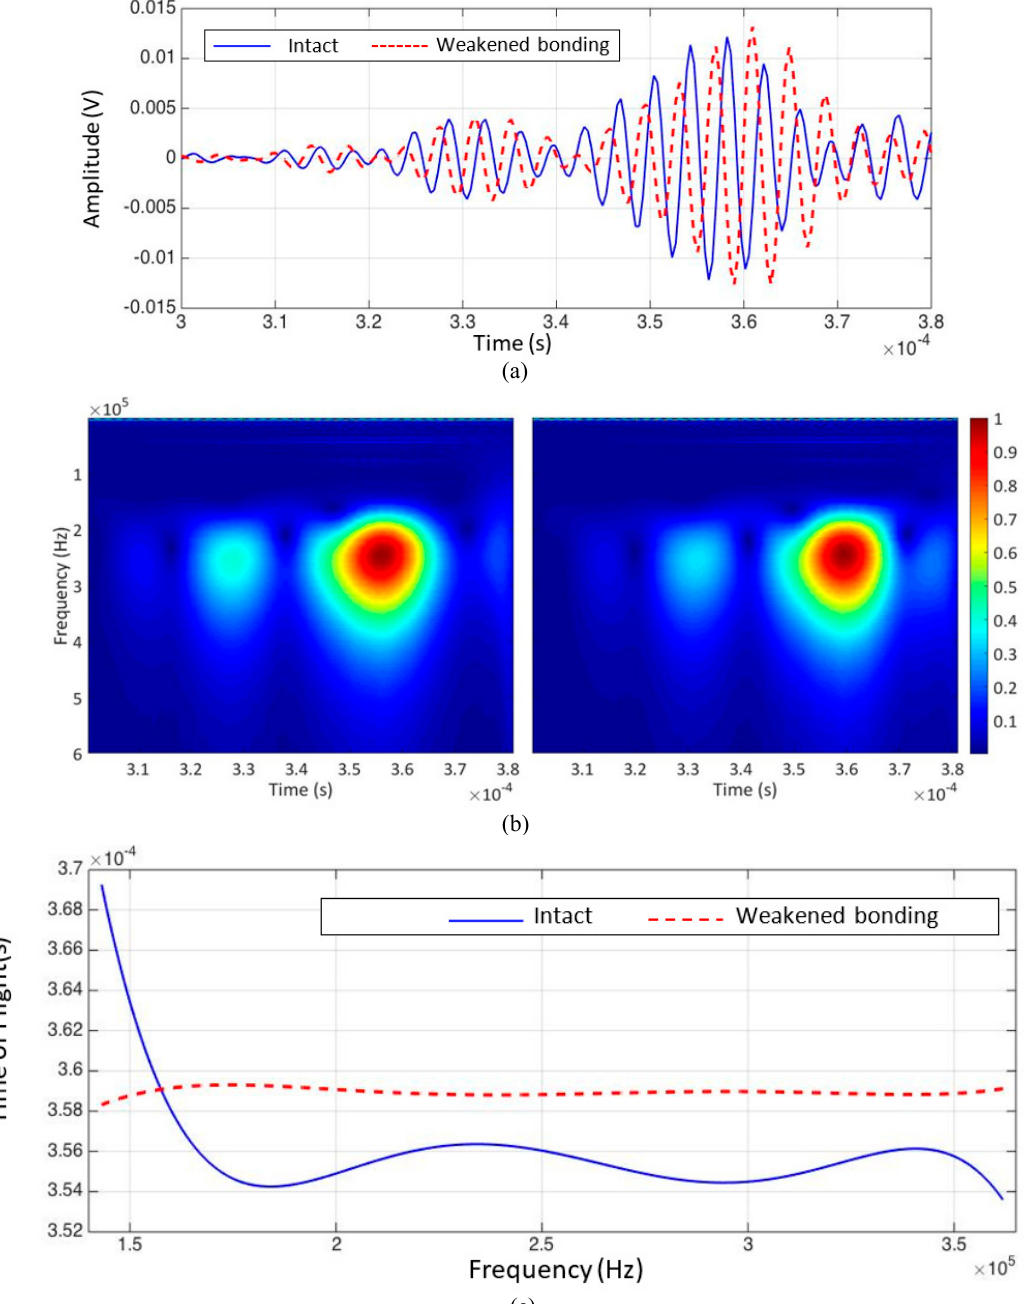
Figure 14. Experimental results: ( a ) two representative signals obtained from intact bonding (blue solid line) and weakened bonding (red dashed line) conditions in the time domain; ( b ) two representative signals obtained from intact (left) and weakened bonding (right) conditions in the time-frequency domain, and ( c ) extraction of TOFs from intact (blue solid line) and weakened bonding (red dashed line) conditions within the frequency range of interest.